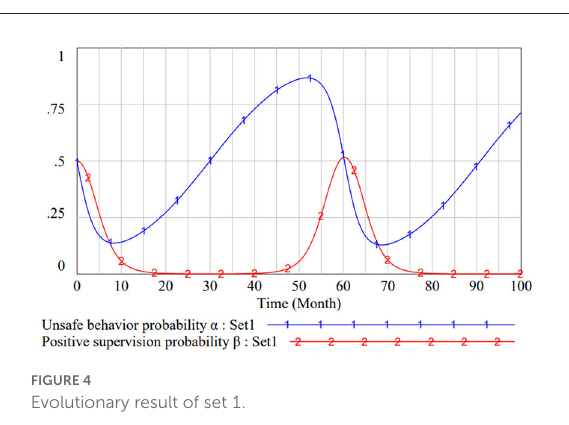
FIGURE4 Evolutionary result of set